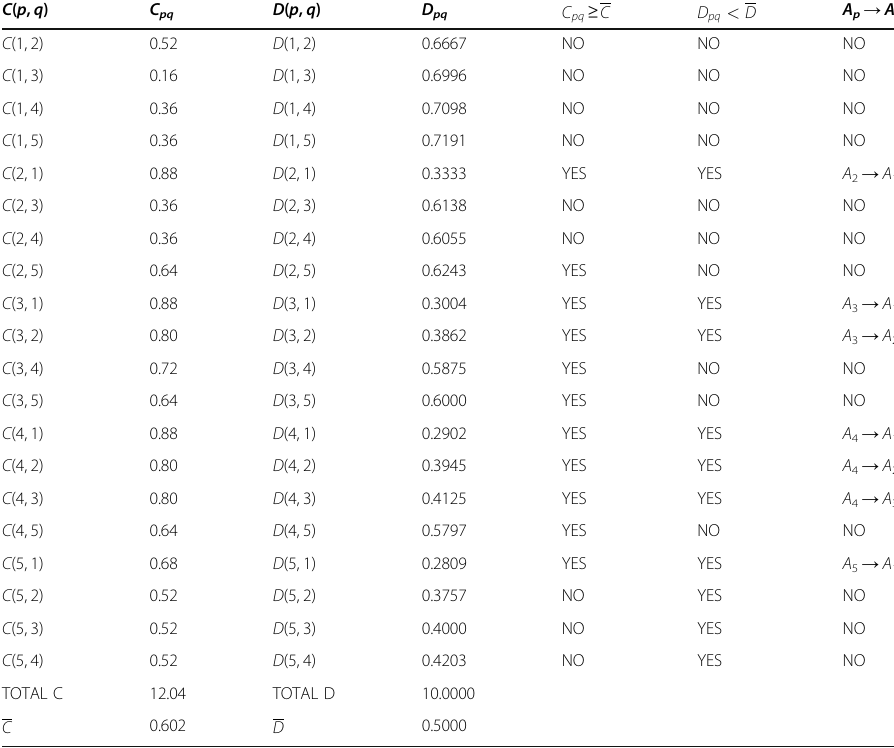
Table 7 Concordance and discordance indices